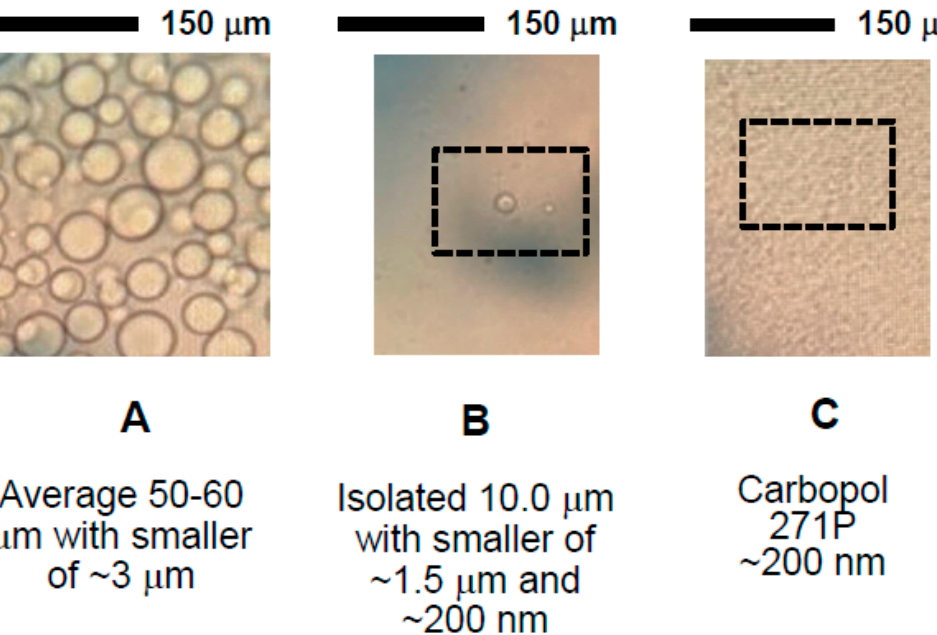
Figure 10. Light microscope images of emulsions formed from 1 mM Tween 80, 0.65 mM betamethasone 21-phosphate and 0.5% w / v carbopol 971P, immediately after formation with large droplets averaging approximately 60 µ m ( A ), a portion of the subnatant after 10 min where with oil droplets ranging from 10 to 1.5 µ m and also some particles estimated to be approximately 200 nm ( B ). The suspended material from a dispersion of 0.5% w / v carbopol 971P was also sampled after 10 min and is indicated the presence of nanoparticles ( C ). All solutions used for samples were prepared from surface chemically pure 50 mM sodium phosphate buffered water, pH